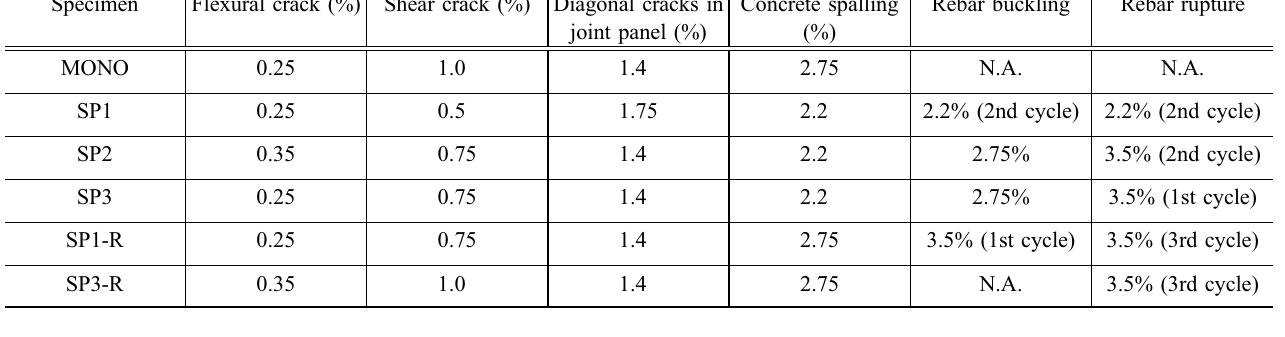
Table 3 Drift ratios corresponding to initiation of each observed damage state.